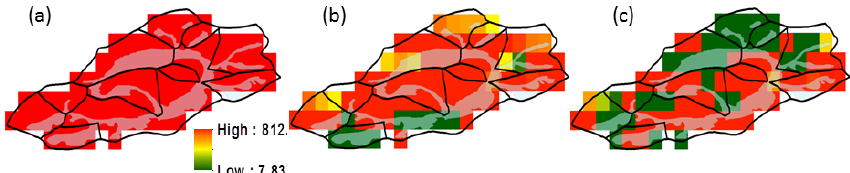
Figure 4. Saturated hydrologic conductivity (mmday − 1 ) as derived from (a) a large-scale FAO soil dataset, (b) a permafrost map of Rieger et al. (1972), and (c) an aspect map of CPCRW is shown. Panels (b) and (c) are small-scale parameterizations obtained from altering large- scale values according to the presence or absence of permafrost. Grid cells that are classified as permafrost soil are assigned hydraulic conductivity 2 orders of magnitude less than the value obtained from the large-scale (FAO) dataset. FAO soils map do not indicate any of the permafrost-underlain soil hydraulic properties which are known to be present in the